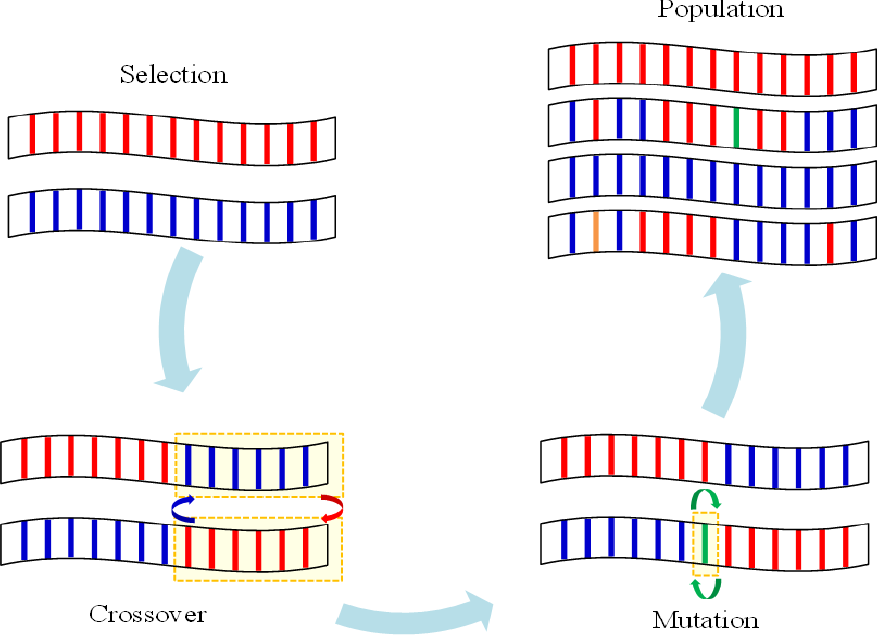
Figure 1. General operation of the genetic algorithm.